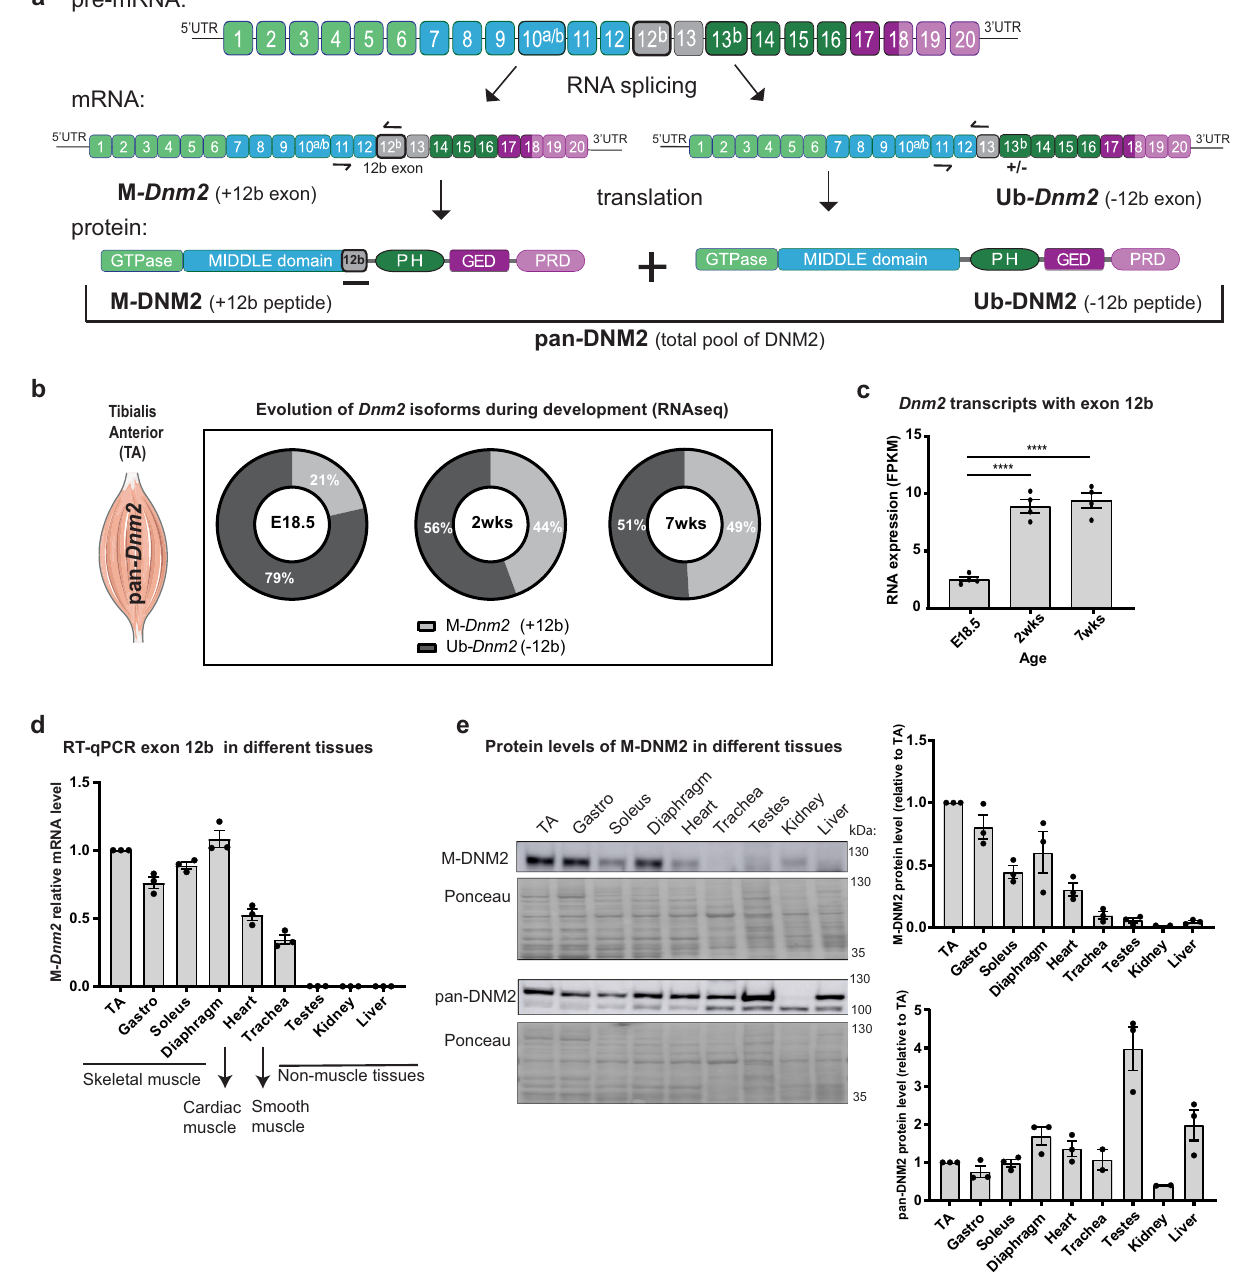
Fig. 1 | Inclusionofexon12b de fi nes a DNM2 isoform onlyexpressedin muscle tissue. a Exonic and protein domain structure of DNM2 isoforms in muscle tissue. On the top, pre-mRNA containing all Dnm2 exons. Exons 10a, 10b, 12b and 13b are alternatively spliced. Dnm2 isoforms containing exon 12b are named as M- Dnm2 (Muscle-speci fi c Dnm2 ),whileisoformsskippingexon12barereferredasUb- Dnm2 (Ubiquitously expressed Dnm2 ). Exon 13b is not found in transcripts containing exon 12b. Ub- Dnm2 isoforms can include or not exon 13b. The position of forward and reverse primers to detect both isoforms is indicated with black arrows in the mRNA. In the protein structure, 12b peptide is predicted to localize between PH (pleckstrin homology) domain and the stalk/middle domain. Pan-DNM2 englobes all DNM2 isoforms (M-DNM2 and Ub-DNM2). GED (GTPase effector domain), PRD (proline rich domain). b RNAseq data from wild-type skeletal muscle at different ages: E18.5 (embryonic day 18.5), 2 weeks and 7 weeks, showing proportions of Dnm2 transcriptscontaining(M- Dnm2 )ornot(Ub- Dnm2 )exon12b( n =4mice/age).